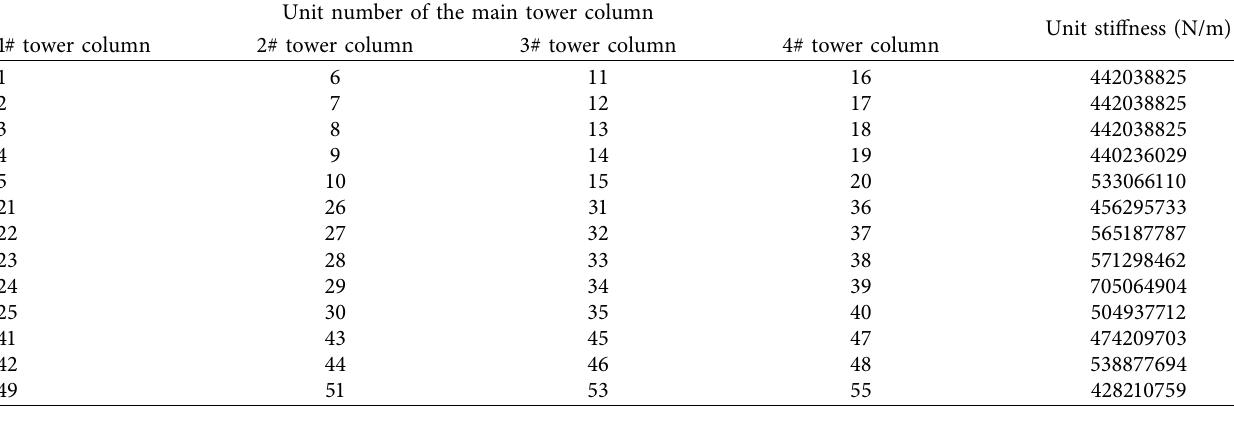
Table 4: Stiffness of the main tower column unit installed with